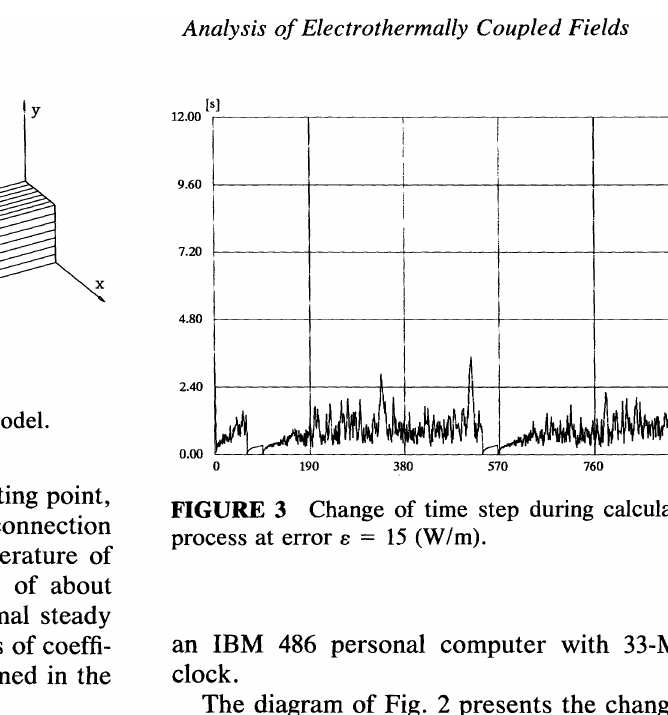
FIGURE 1 Discretization of the model.